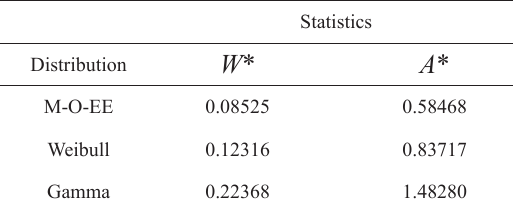
MLEs of the model parameters and log-likelihood